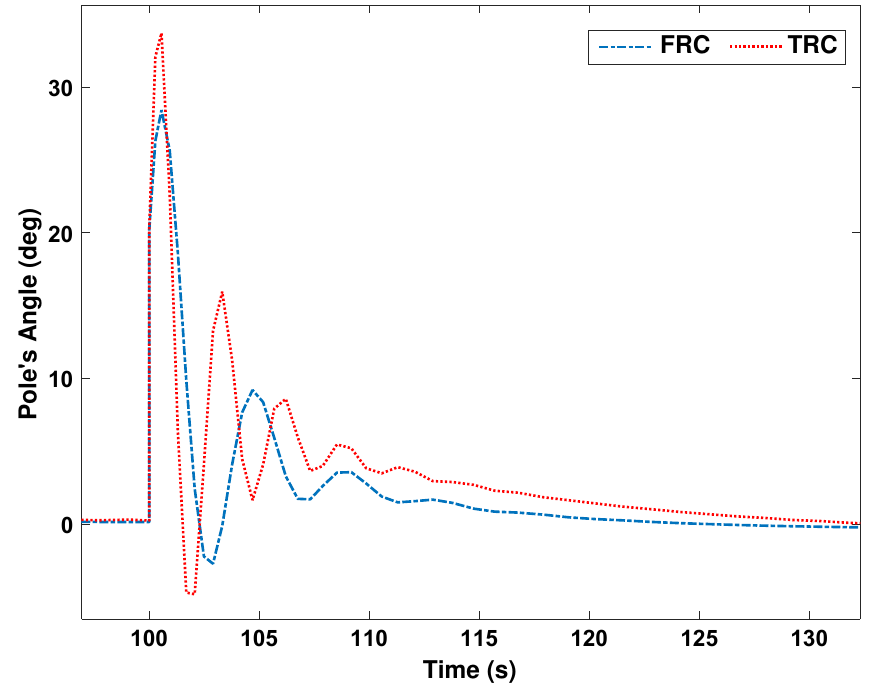
Figure 11. Zoom an area of Figure 10.